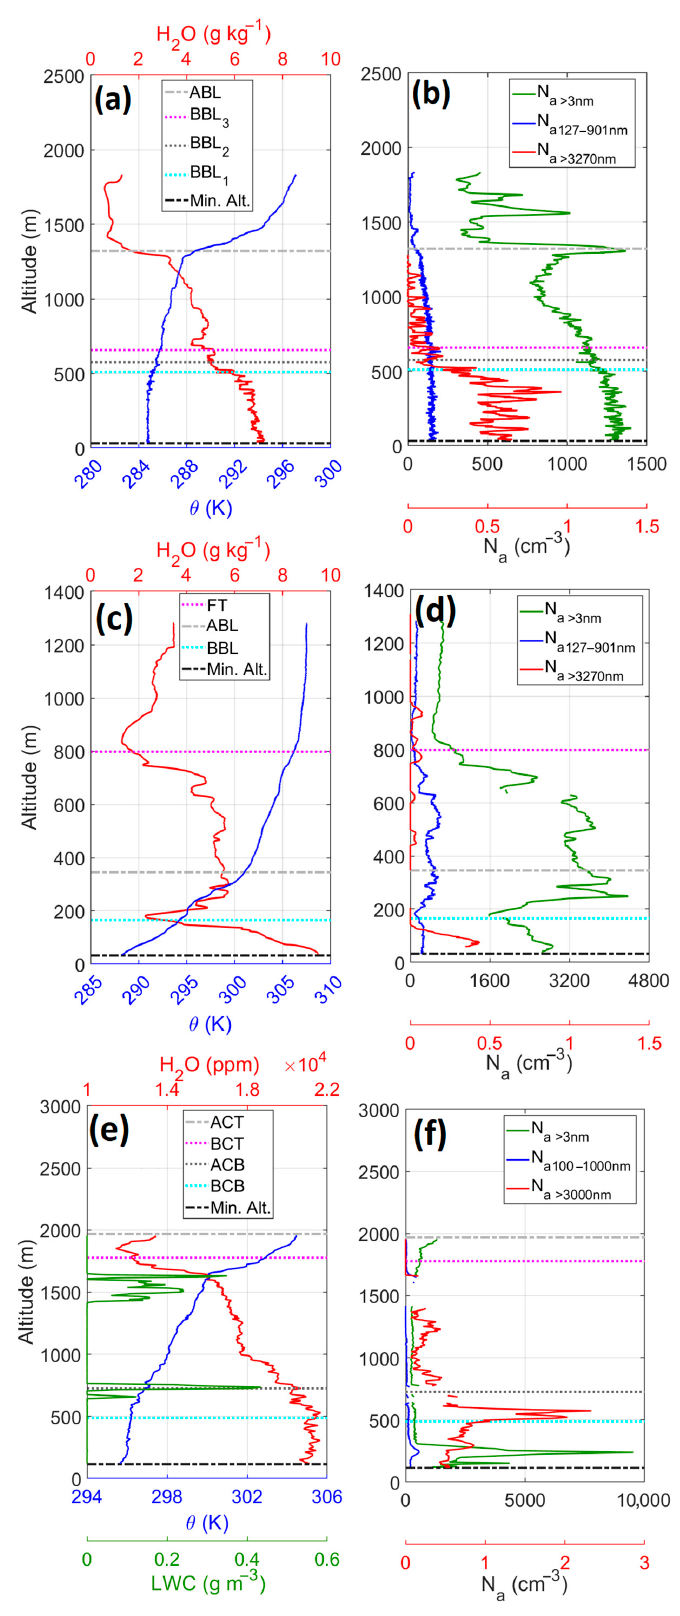
Figure 6. Sounding data for MONARC research flights (RFs) 8 (6 June 2019) and 11 (11 June 2019) and ACTIVATE RF 24 (17 August 2020) in which MBLs were not well mixed. Top ( a , b ), middle ( c , d ), and bottom ( e , f ) are associated with MONARC RF08, MONARC RF11, and ACTIVATE